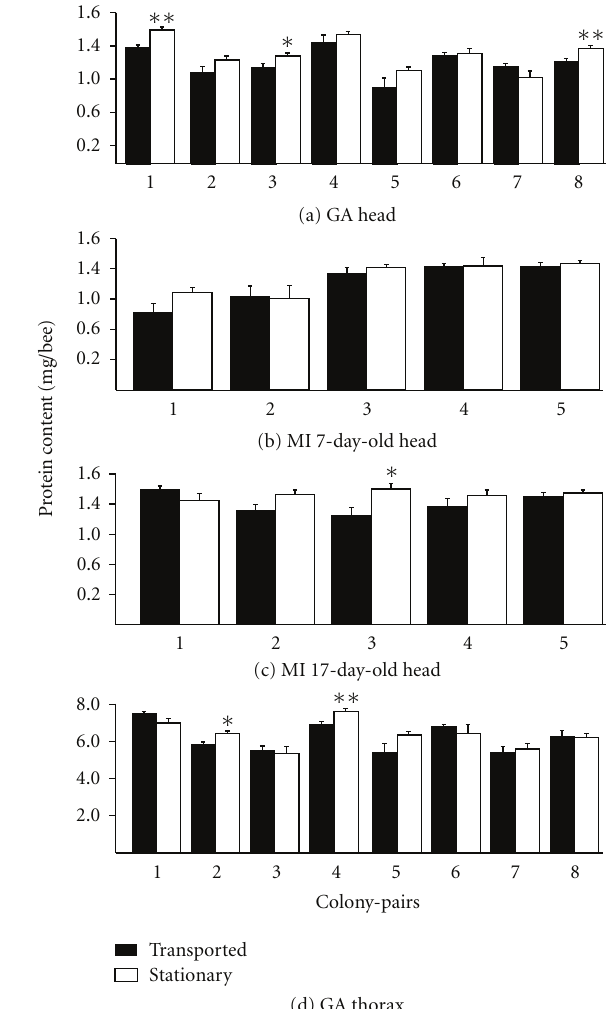
Figure 3: Protein content (mean ± SE) in worker honey bees experiencing transportation (solid) or no transportation (open) in heads ((a), (b), (c)) or thorax (d). For more details, see Figure 1